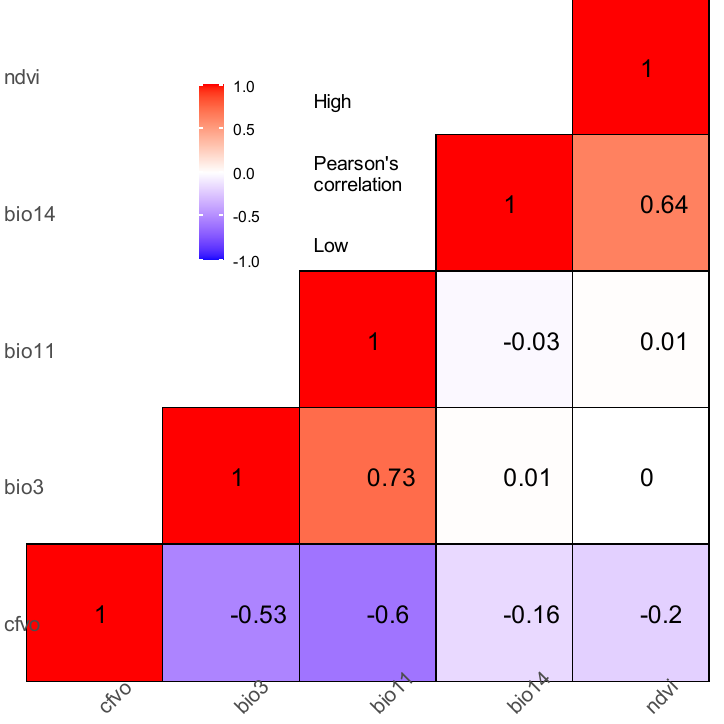
Figure 3. Heat map depicting the pairwise correlation of considered environmental variables (Pearson’s correlation coefficient threshold; r = ± 0.8) used in predictive distribution modelling of Pinus gerardiana .